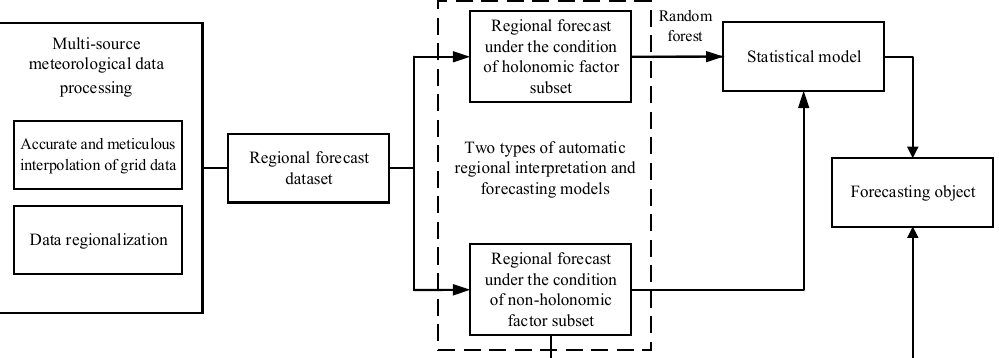
Figure 5. ML-MOS model framework.